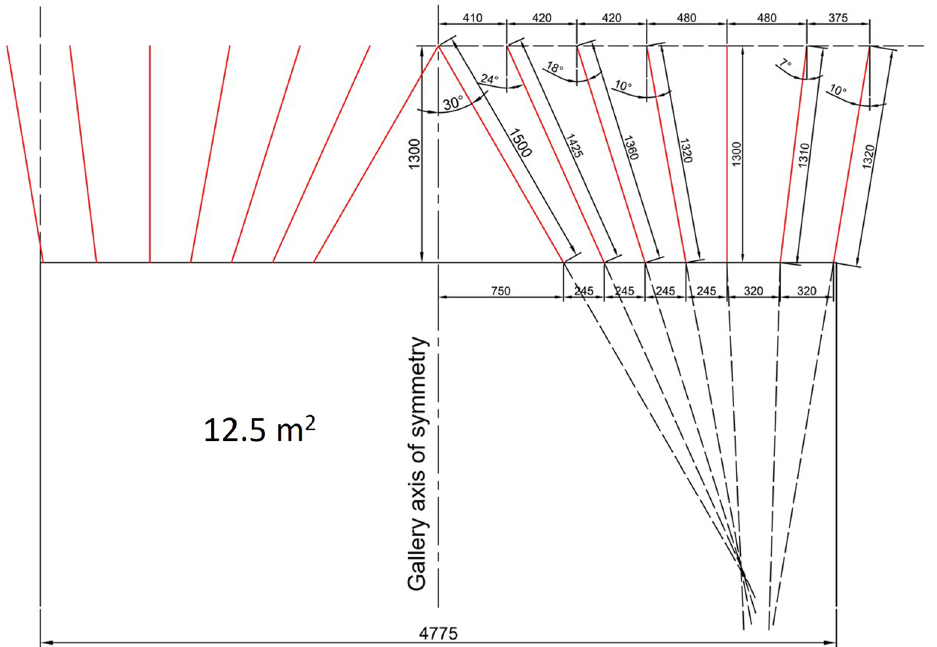
Figure 12. The arrangement of single V cut